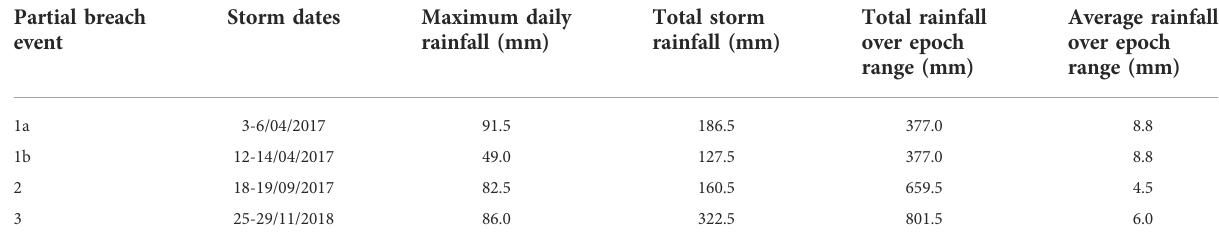
TABLE 4 Rainfall at Clinton Ridge weather station (data provided by ECAN) for the storms correlating with the three signi fi cant partialbreach events. 1a and 1b are Cyclones Debbie and Cook,